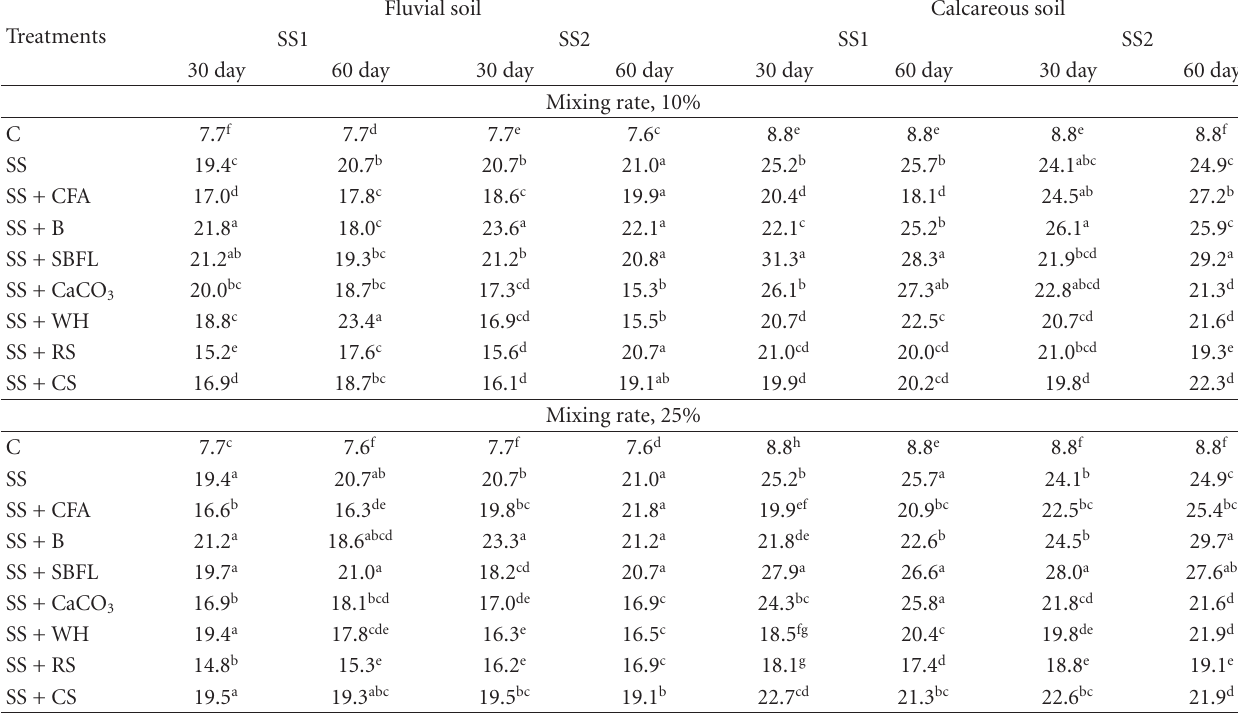
Table 4: E ff ect of SS and stabilized SS on Olsen-P in relation to soil type, sewage source, mixing rate, and incubation period.